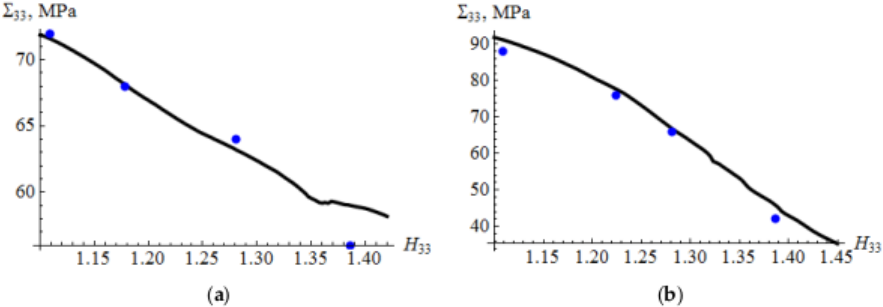
Figure 3. Dependences of stress intensity Σ u = Σ 33 on H 33 obtained through modeling and during the experimental tensile tests (dots) of 1420 alloy [16] for the initial strain rate: ( a ) D 0 = 3.33 · 10 − 4 s − 1 (identification), ( b ) D 0 = 3.33 · 10 − 3 s − 1 (verification).